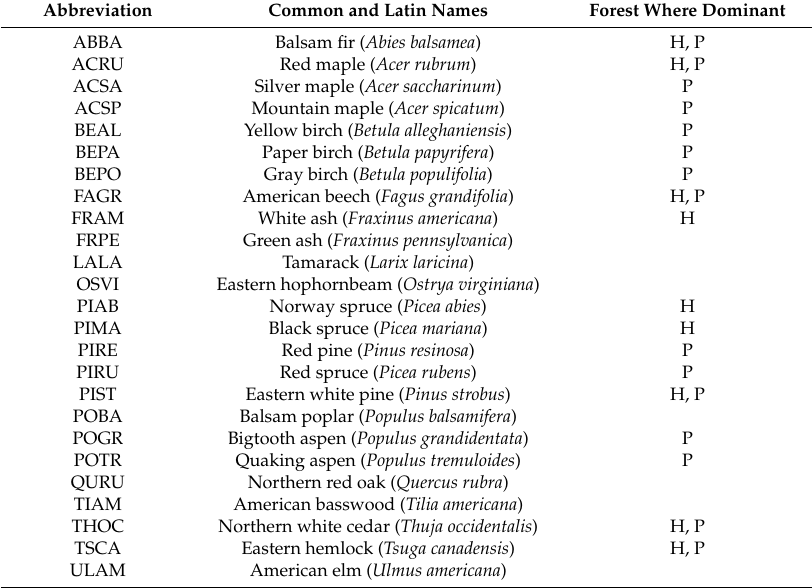
Table 3. Tree species abbreviations. Species dominant in one or more subplots in either forest are denoted with a letter indicating the forest name: H for Howland Experimental Forest and P for Penobscot Experimental Forest. Species not followed by a letter are not the dominant species in any subplot from either